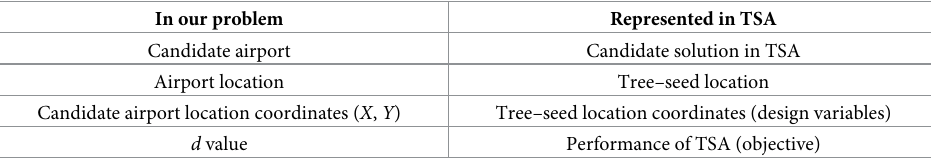
Table 1. Adapting the study to the